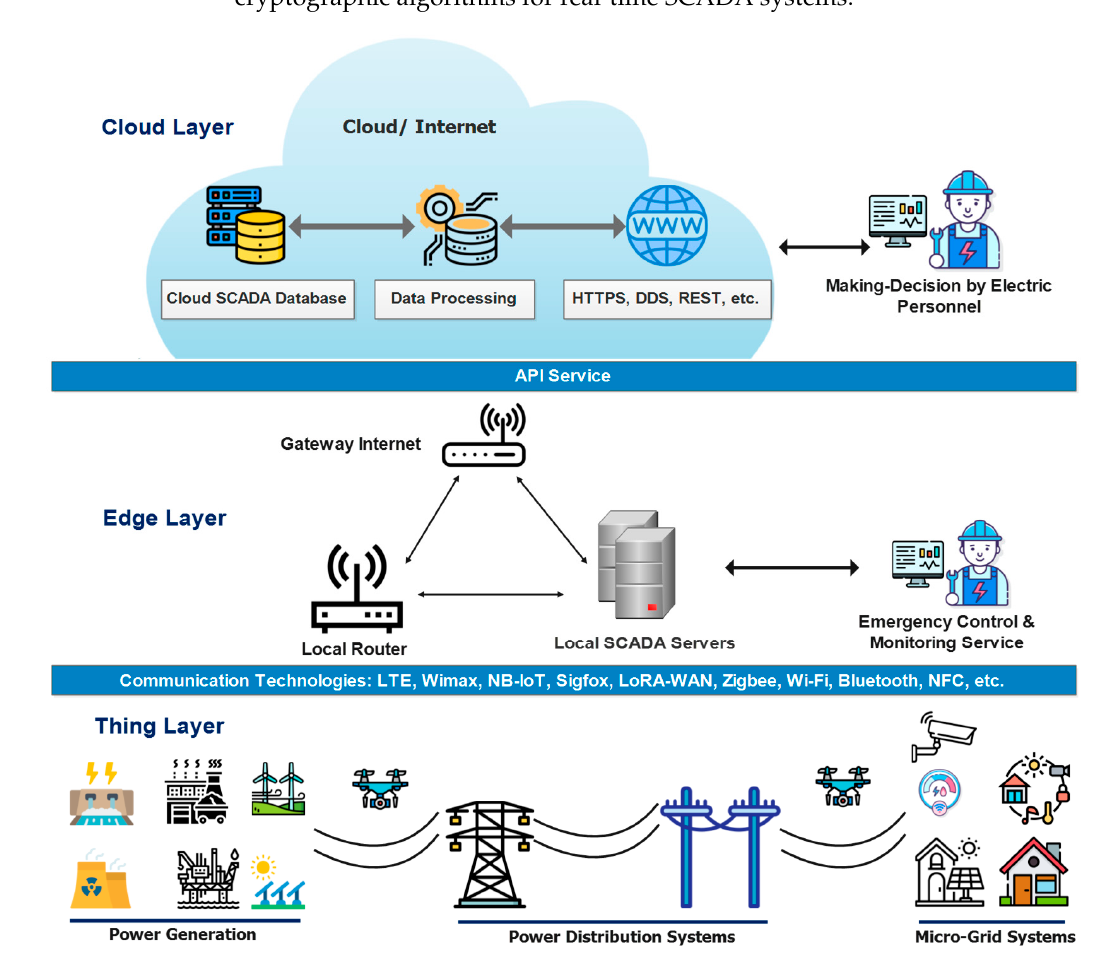
Figure 5. An illustration of the overall SCADA architecture based on edge-cloud computing.